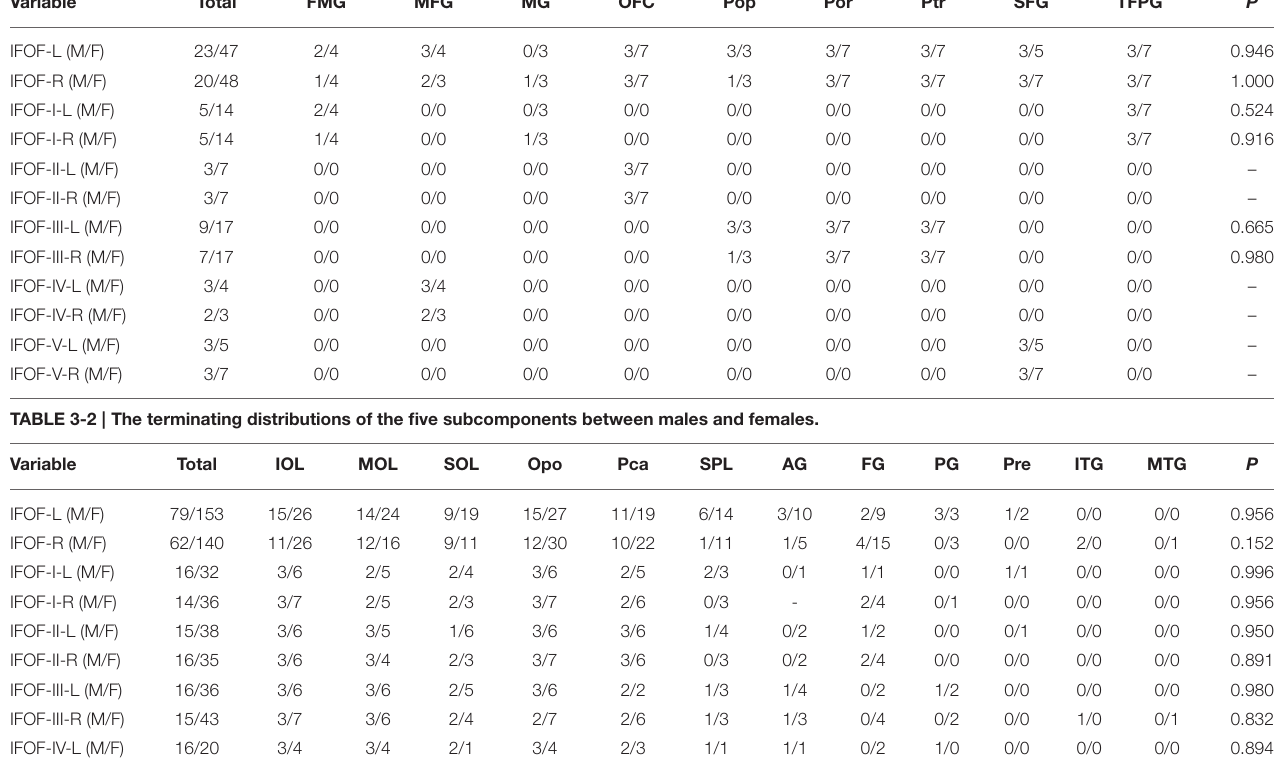
TABLE 3-1 | The originating distributions of the five subcomponents between males and females. Variable